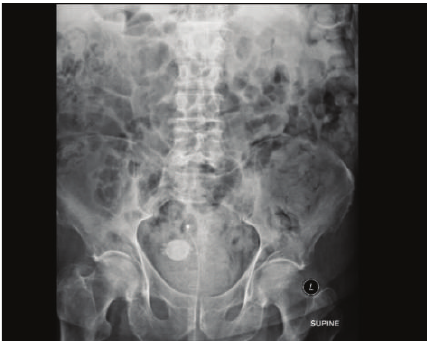
Figure 1: Plain abdominal radiograph clearly showing spiculated bladder calculi.